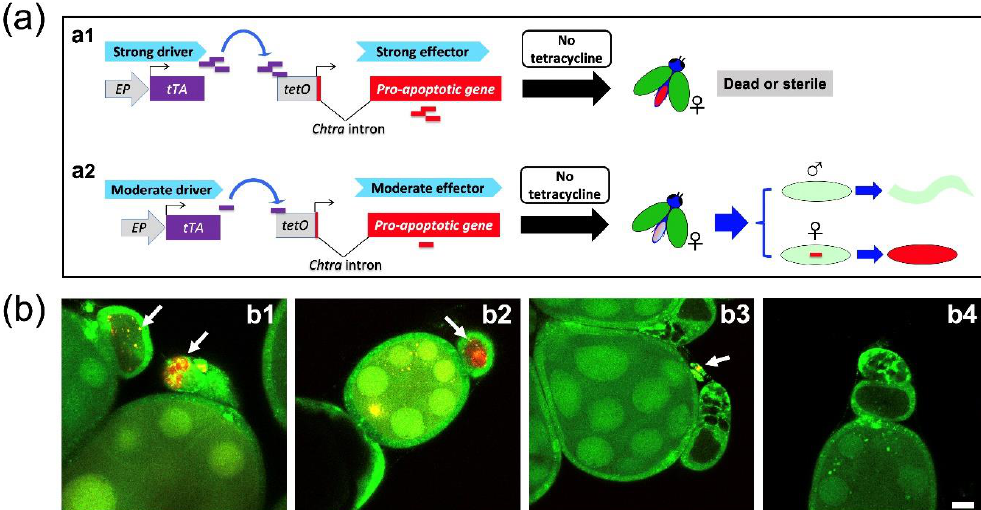
Figure 2. “Moderate driver and e ff ector” strategy to improve the transgenic embryonic sexing system (TESS) of L. cuprina . ( a ) Schematic illustration for the transgenic embryonic sexing system (TESS) containing driver and e ff ector components. The driver used an early promoter (EP) to drive the tetracycline transactivator ( tTA ), and the e ff ector contains a sex-specific intron ( Chtra which immediately follows the ATG translation start codon of pro-apoptotic gene) splicing cassette within a pro-apoptotic gene to achieve highly e ffi cient female lethality early in the development of L. cuprina . Unless adults are fed diet with tetracycline, females are sterile and short-lived if the early promoter is also active in female ovaries and the e ff ector is strongly activated by tTA (a1) [16,17,21]. However, a combination of moderate driver and e ff ector could reduce such “leaky” cell death in females thus an additional tetracycline supply may not be necessary (a2). ( b ) Confocal images of fluorescent ovaries. The images were taken using dissected ovaries from 4 d (b1, b3) and 8 d (b2, b4) old females, which were generated by crossing homozygous males from DR3#4 (b1, b2) or DR2#7 (b3, b4) with homozygous virgin females from EF-RFPex [21]. DsRed expression (indicated by white arrows) was observed in the early portion of the developing eggs (germarium). The nurse cells showed green fluorescence from the marker. Scale bar: 20 µ